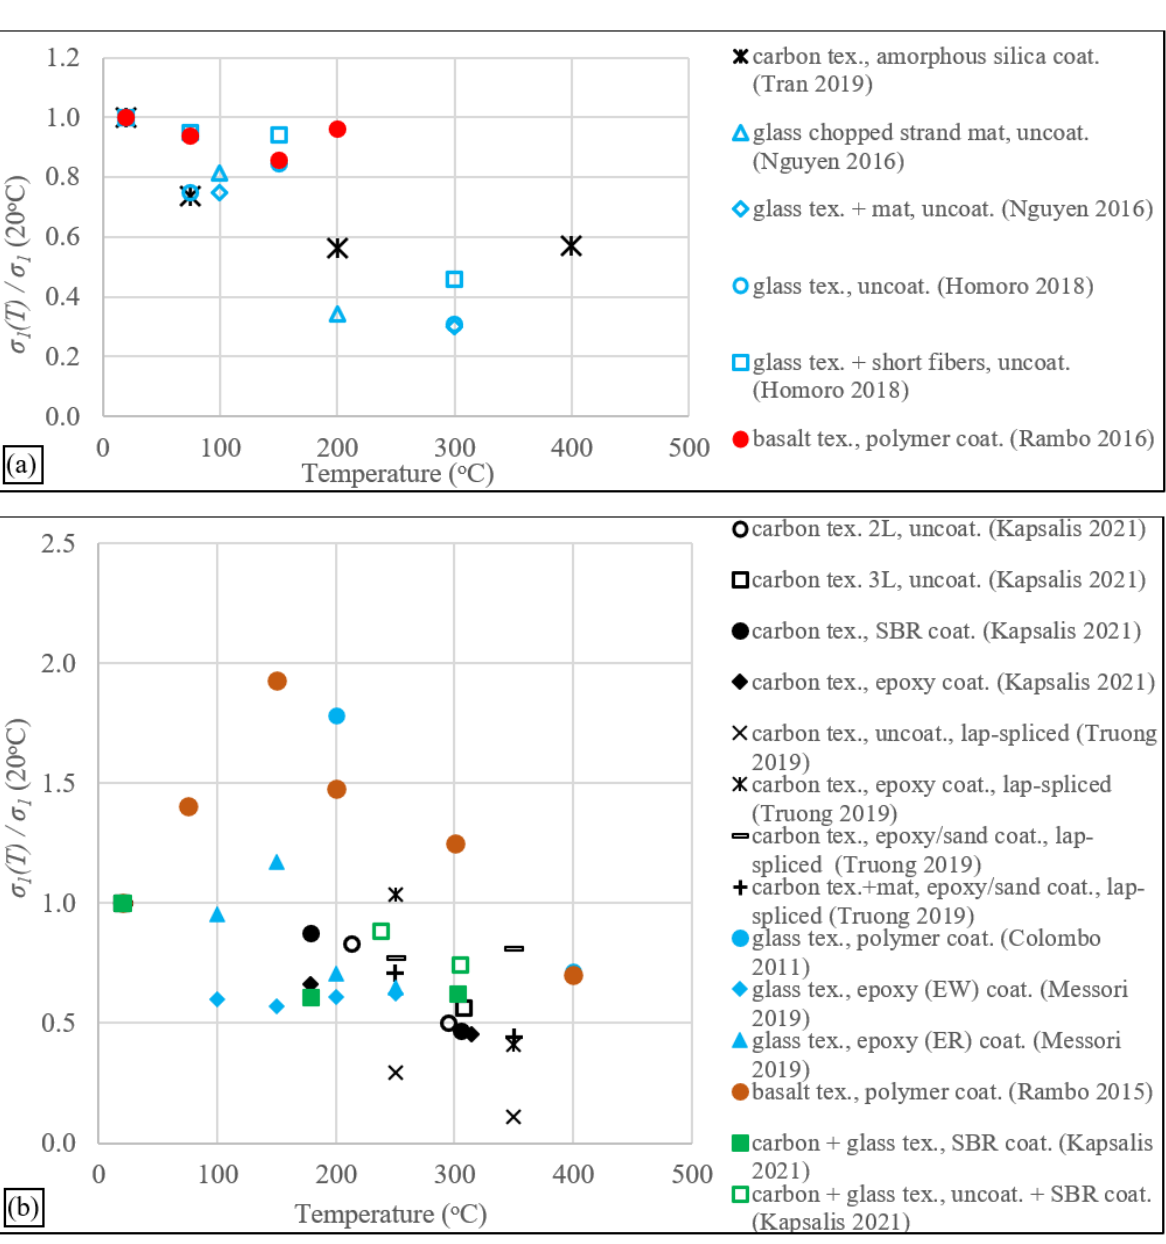
Figure 3. First cracking stress ( σ 1 ) versus exposure temperature for various TRC compositions; ( a ) specimens loaded while in heated conditions; ( b ) specimens tested after cooling down.